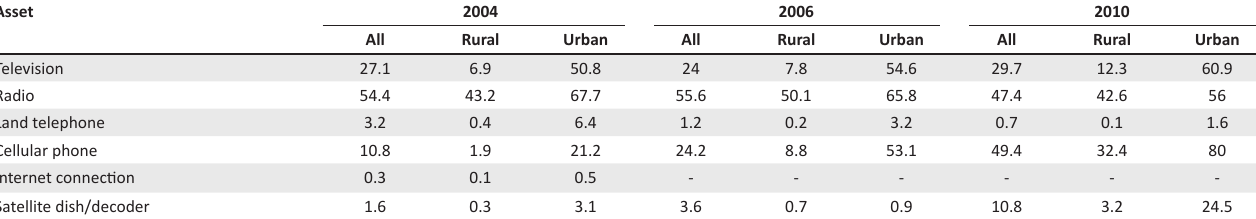
TABLE 5: Trend in access to Information and Communication Technologies assets from 2004 to 2010 in percentages. Asset